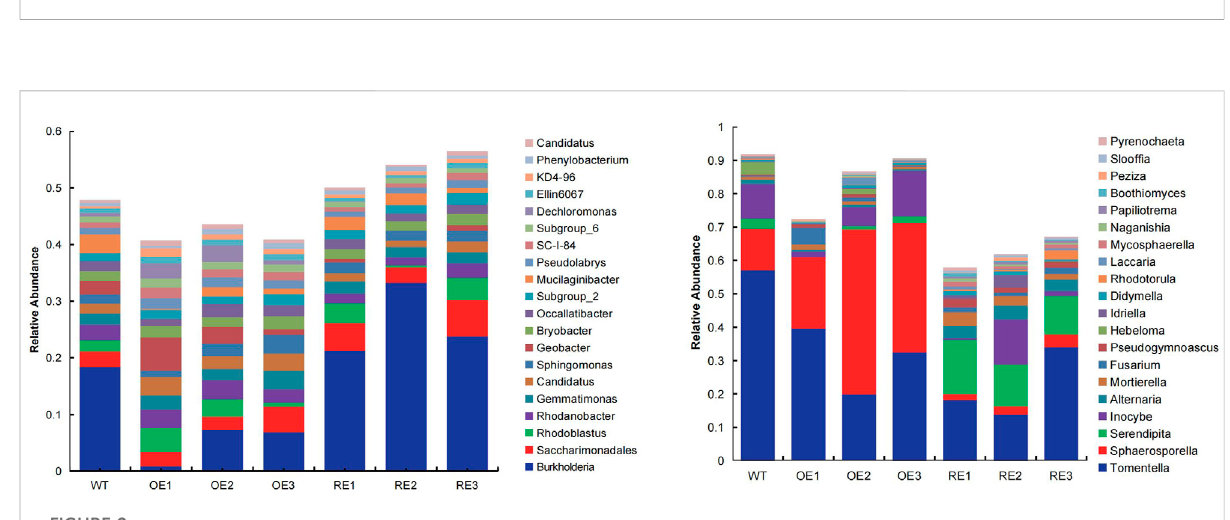
FIGURE 1 Comparison of rhizosphere soil enzyme activities between transgenic lines and WT. (A) Sucrase activity (B) Urease activity (C) Catalase activity (D) Neutral protease activity (E) Cellulase activity.